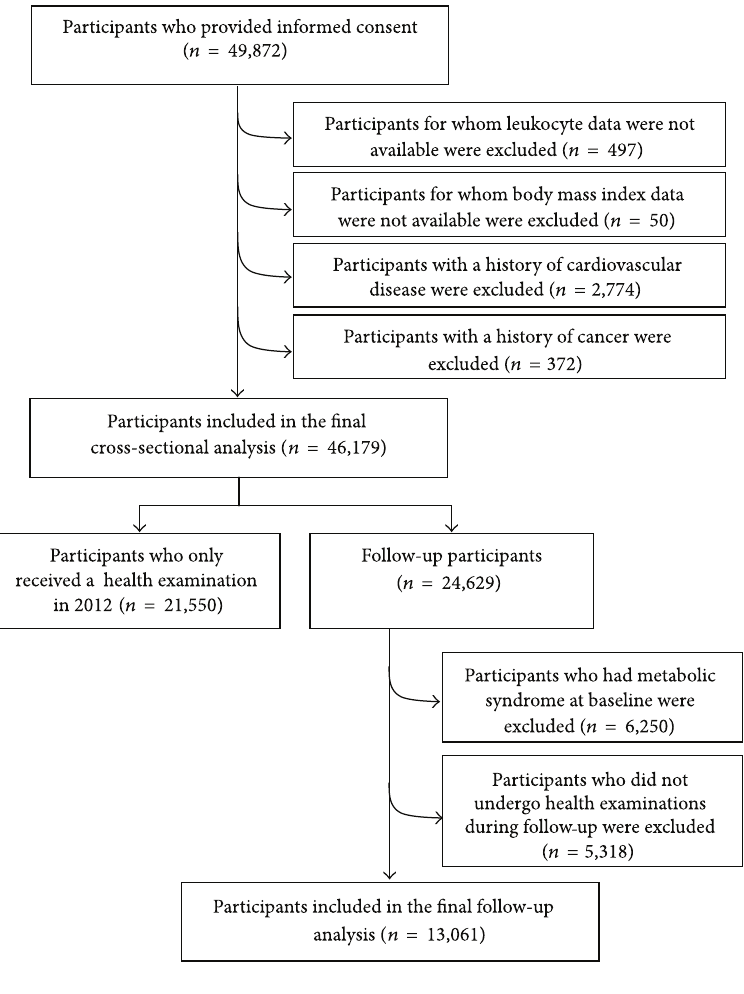
Figure 1: Selection of the study population, Tianjin chronic low-grade inflammation and health (TCLIH) cohort study, 2007 to 2012.